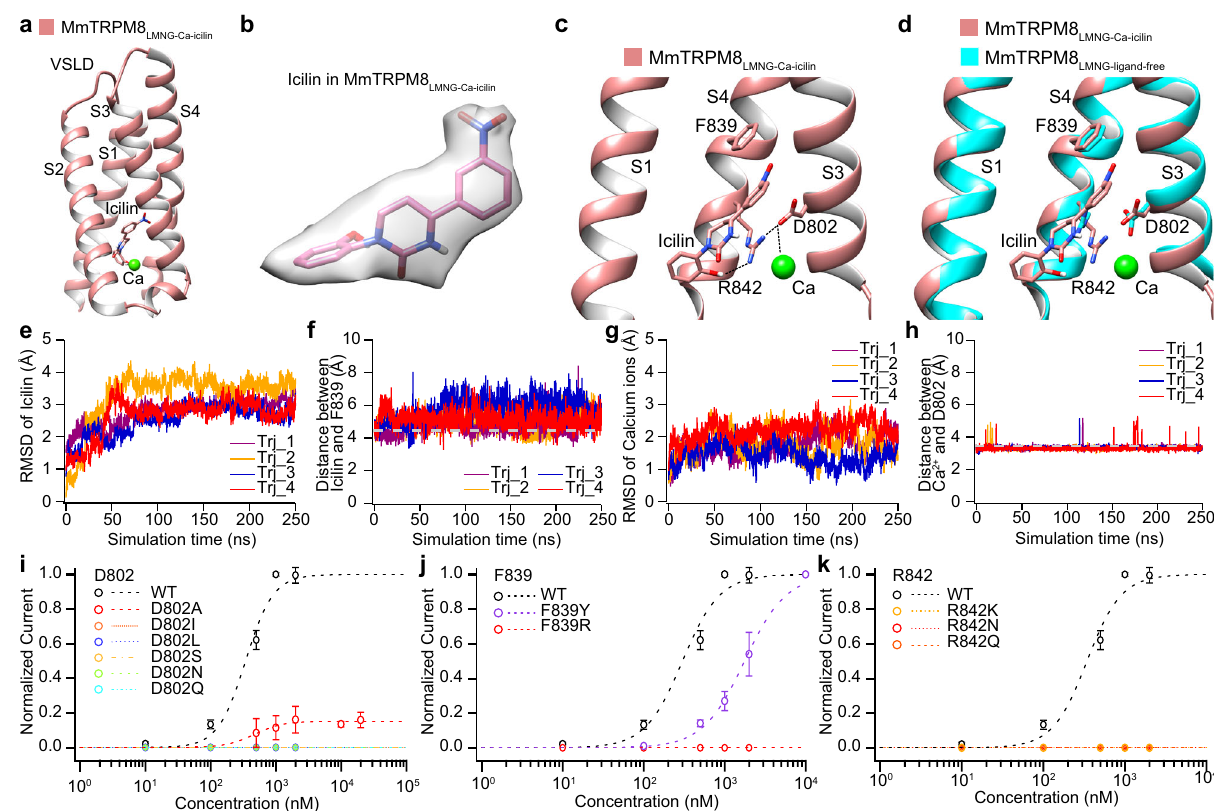
Fig. 6 Structural basis and MD simulation for the icilin recognition. a The Ca 2 + and icilin binding sites in the VSLD of MmTRPM8 LMNG-Ca-icilin . b The icilin density in MmTRPM8 LMNG-Ca-icilin at the level of 0.015 in UCSF chimera. c Interactions between MmTRPM8 and Ca 2 + and icilin. d The binding of Ca 2 + and icilin induces local conformational change revealed by structural comparison of MmTRPM8 LMNG-Ca-icilin (salmon) and MmTRPM8 LMNG-ligand-free (cyan). e The RMSD of icilin plotted against simulation time. f The distance between the N21 atom in icilin and CG atom in Phe839 plotted against simulation time. g The RMSD of Ca 2 + plotted against simulation time. h The distance between the Ca 2 + and CG atom in Asp802 plotted against simulation time. i – k Concentration-dependent icilin activation of Asp802, Phe839, and Arg842 mutants in comparison with WT MmTRPM8 in whole-cell patch-clamp recordings (For WT MmTRPM8, n = 5; for D802A, D802I, D802L, D802S, D802N, D802Q, F839R, F839Y, R842K, R842N, and R842Q, n = 3). All data points are mean ± s.e.m. For e – k , source data are provided as a Source Data fi